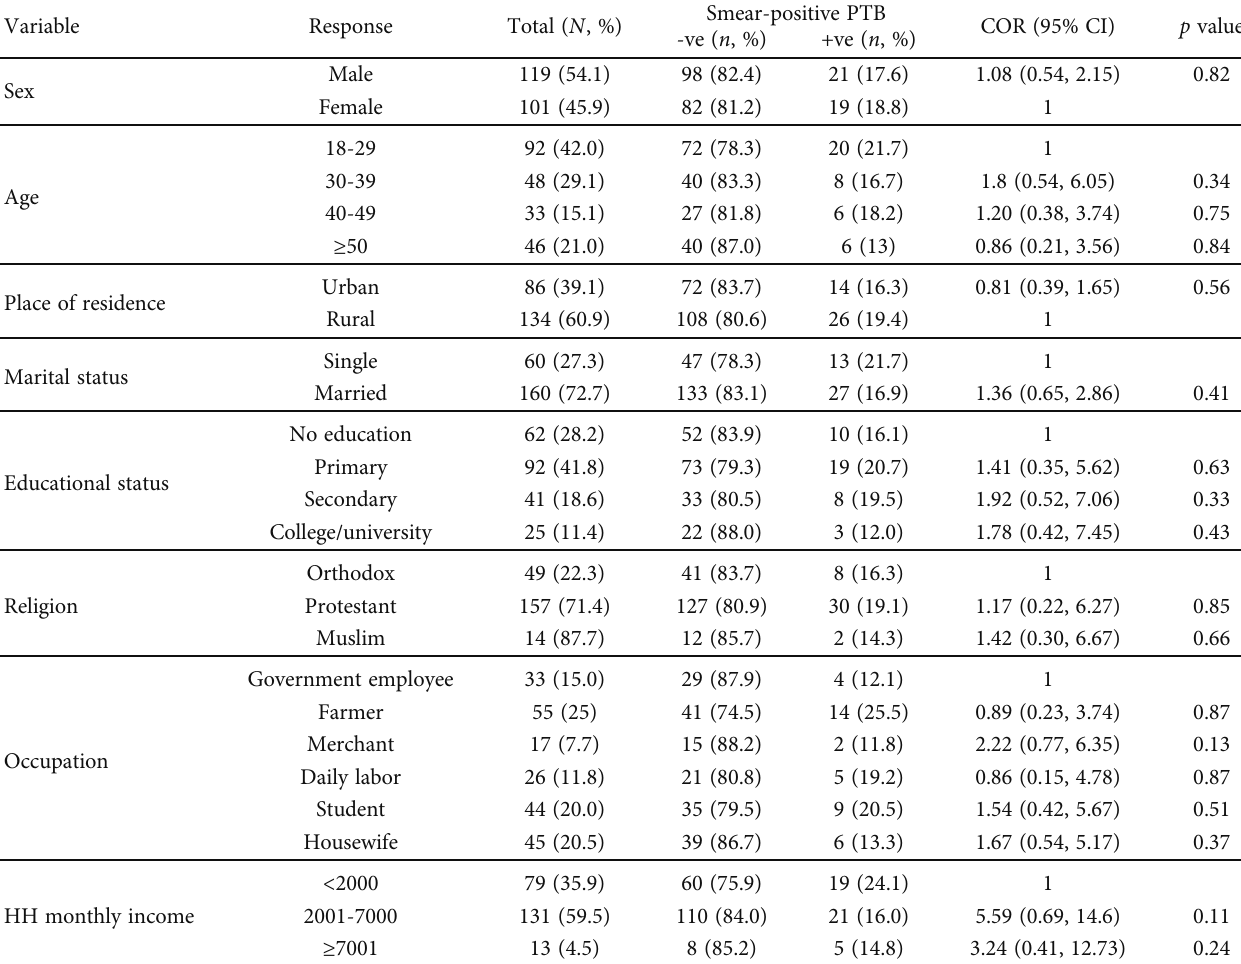
Table 1: Sociodemographic characteristics of TB-suspected patients with smear-positive PTB and prevalence.